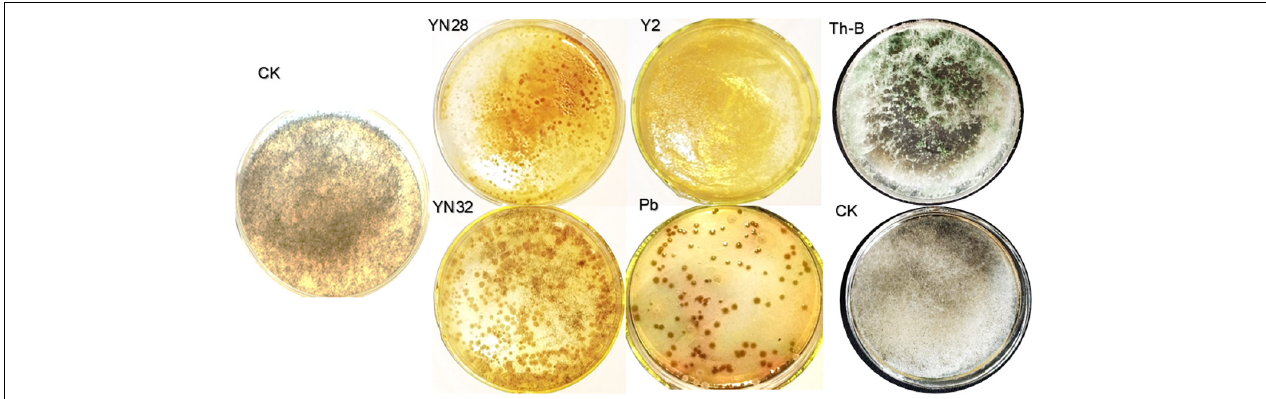
FIGURE 2 | Tobacco leaf disc interaction test. Both sides of leaf discs were sprayed by prepared spore suspension using a manual sprayer. Spore suspension of the pathogen and candidate biocontrol strains brought in interaction in the growth chamber for 5 h. An aliquot of 200 µ L of dilutions was spread on a PDA plate and incubated at 32 ◦ C for 3 days.